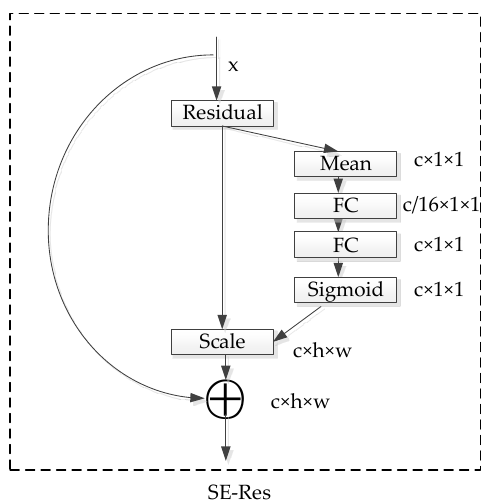
Figure 7. Schematic diagram of the Squeeze-and-Excitation residual(SE-Res) module.